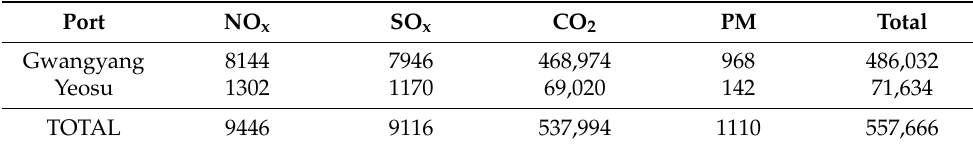
Table 9. Ship emissions by pollutant. (unit: